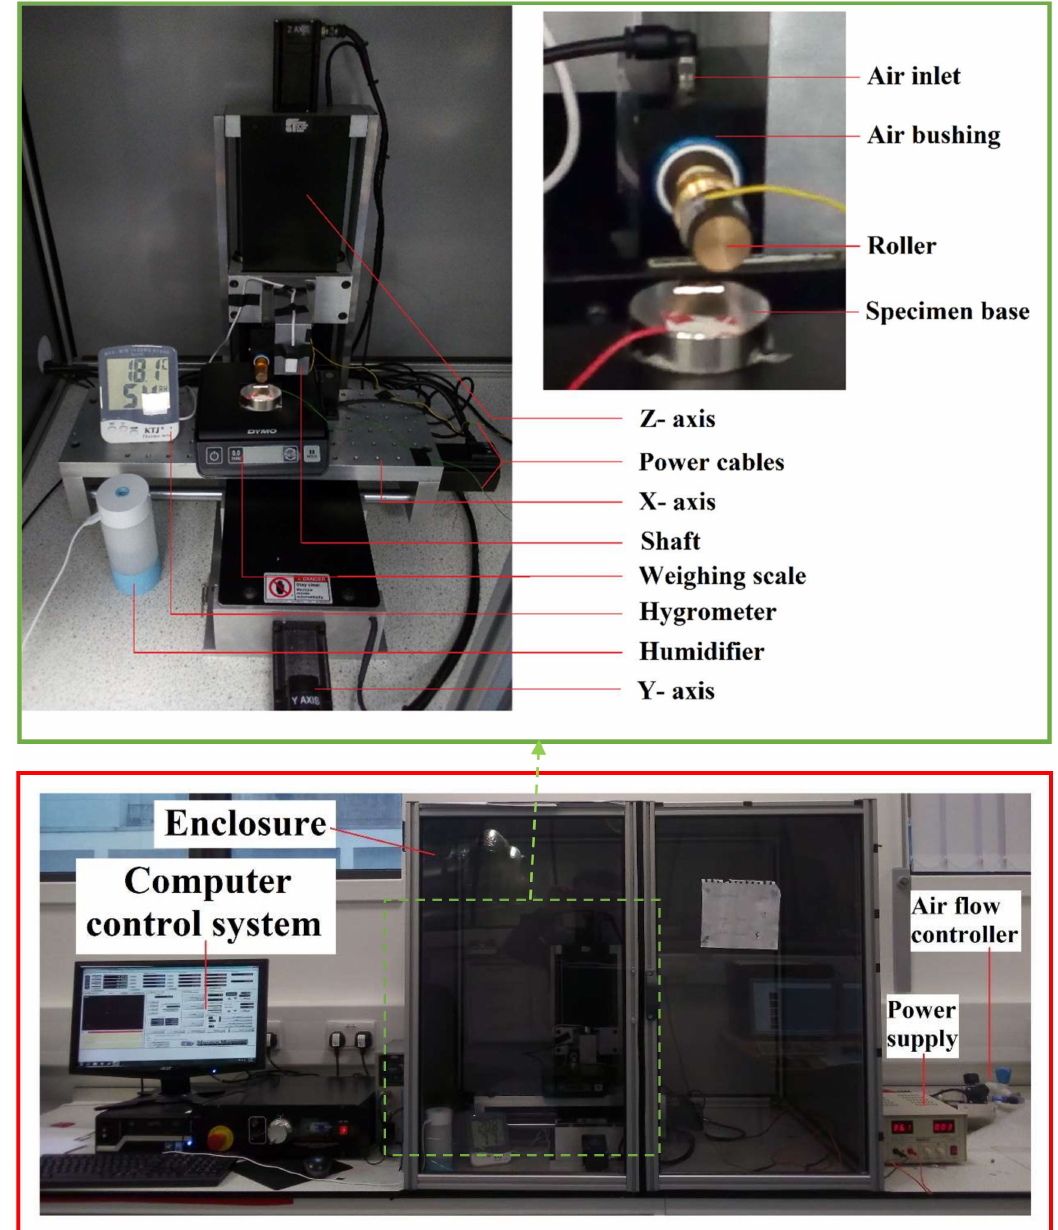
Figure 6. Overview of the implemented rolling nanoelectrode nanolithography (R-NEL)